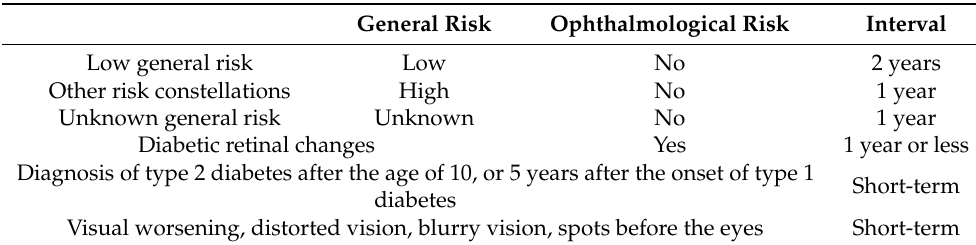
Table 2. The time interval proposed for ophthalmological examinations [33]. General Risk Ophthalmological Risk Interval Low general risk Low No 2 years Other risk constellations High No 1 year Unknown general risk Unknown No 1 year Diabetic retinal changes Yes 1 year or less Diagnosis of type 2 diabetes after the age of 10, or 5 years after the onset of type 1 Short-term diabetes Visual worsening, distorted vision, blurry vision, spots before the eyes